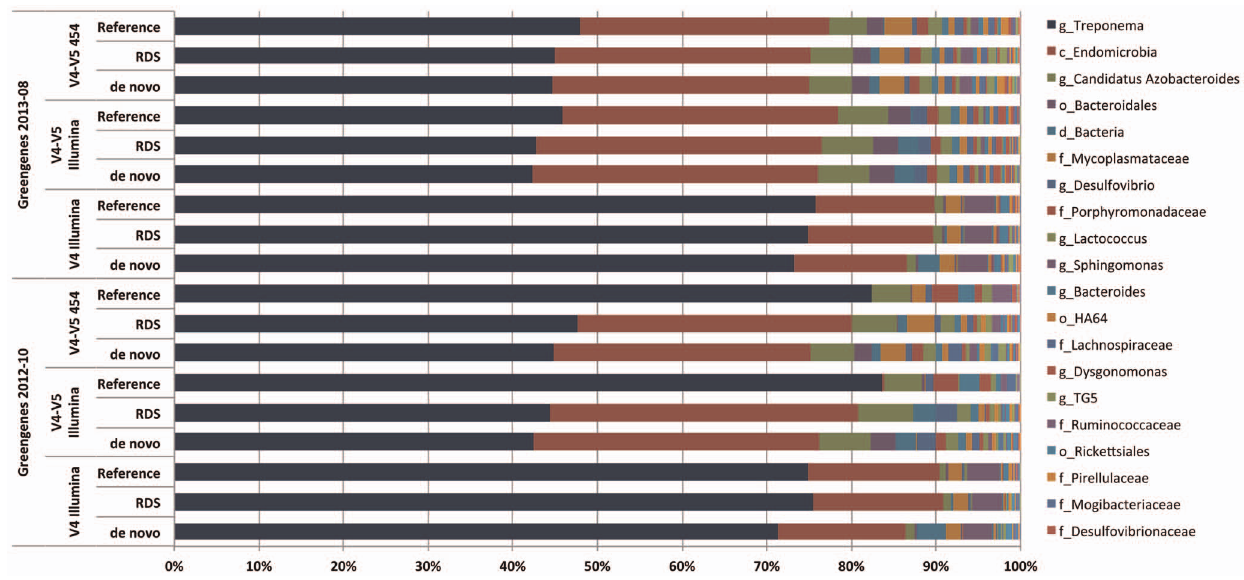
Figure 5. Effects of processing method and Greengenes database version on the taxonomic composition of the termite datasets. Plot comparing the taxonomic composition of the termite hindgut sample for the three different library types sequenced when processed using three different methods. The replicate V4 and V4-V5 Illumina datasets were combined into one representative dataset for each library type. Taxonomic assignments were made using the RDP Classifier after retraining with either the 2012–10 or 2013–08 Greengenes references. Taxonomic ranks are noted by letters preceding the taxon name as follows: genus – g, family – f, order – o, class – c, phylum – p, domain – d.